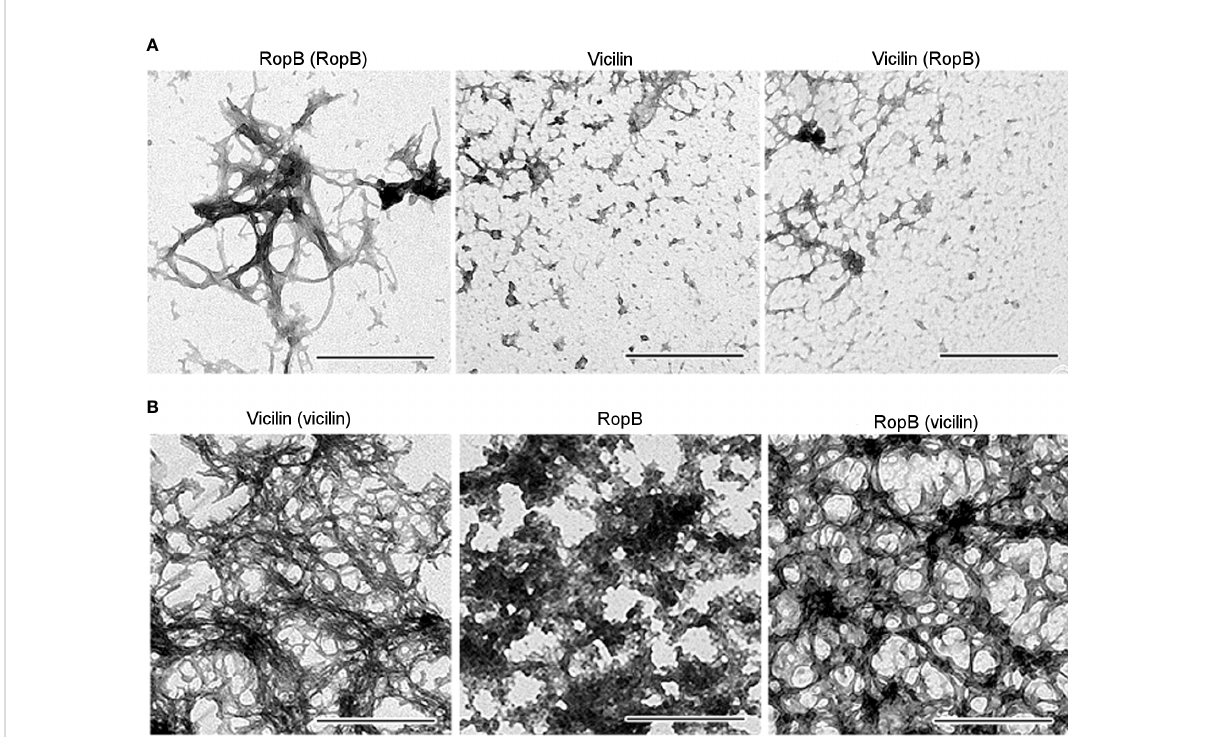
FIGURE 5 (A) TEM images of the RopB fi brils prepared with seeding by pre-incubated RopB aggregates (left panel), vicilin aggregates (middle panel), and vicilin aggregates prepared with cross-seeding by pre-incubated RopB fi brils (right panel). The scale bars are equal to 500 nm. (B) TEM images of the vicilin fi brils prepared with seeding by pre-incubated vicilin aggregates (left panel), RopB unstructured aggregates (middle panel), and RopB fi brils prepared with cross-seeding by pre-incubated vicilin amyloids (right panel). The scale bars are equal to 500